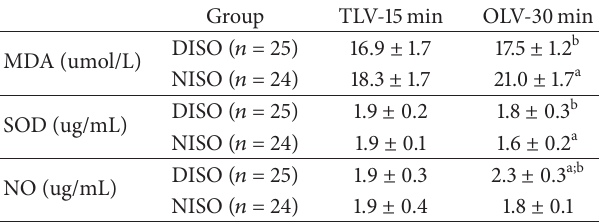
Table 3: Changes in MDA level, SOD activity, and NO concentra- tion in DISO group and NISO group ( 𝑥 ± 𝑠